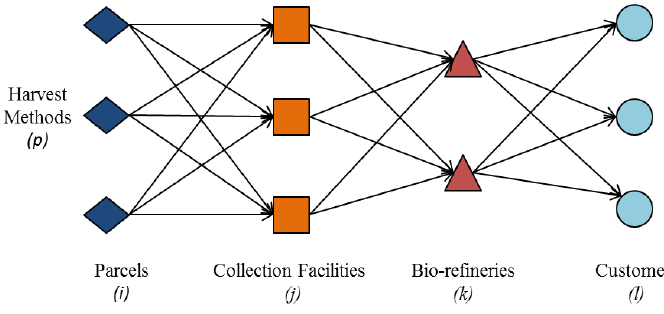
Figure 4. Schematic Diagram of a Bioenergy Supply Chain Network.